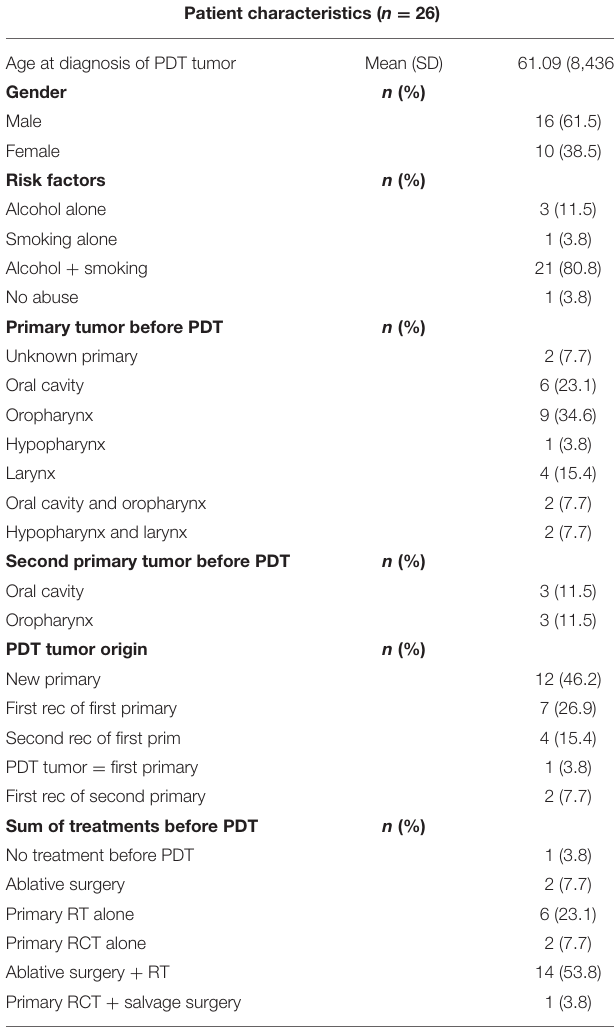
TABLE 1 | Patient characteristics: Age, gender, and risk factors for n = 26 patients, with oral cavity and/or oropharyngeal cancer treated with photodynamic